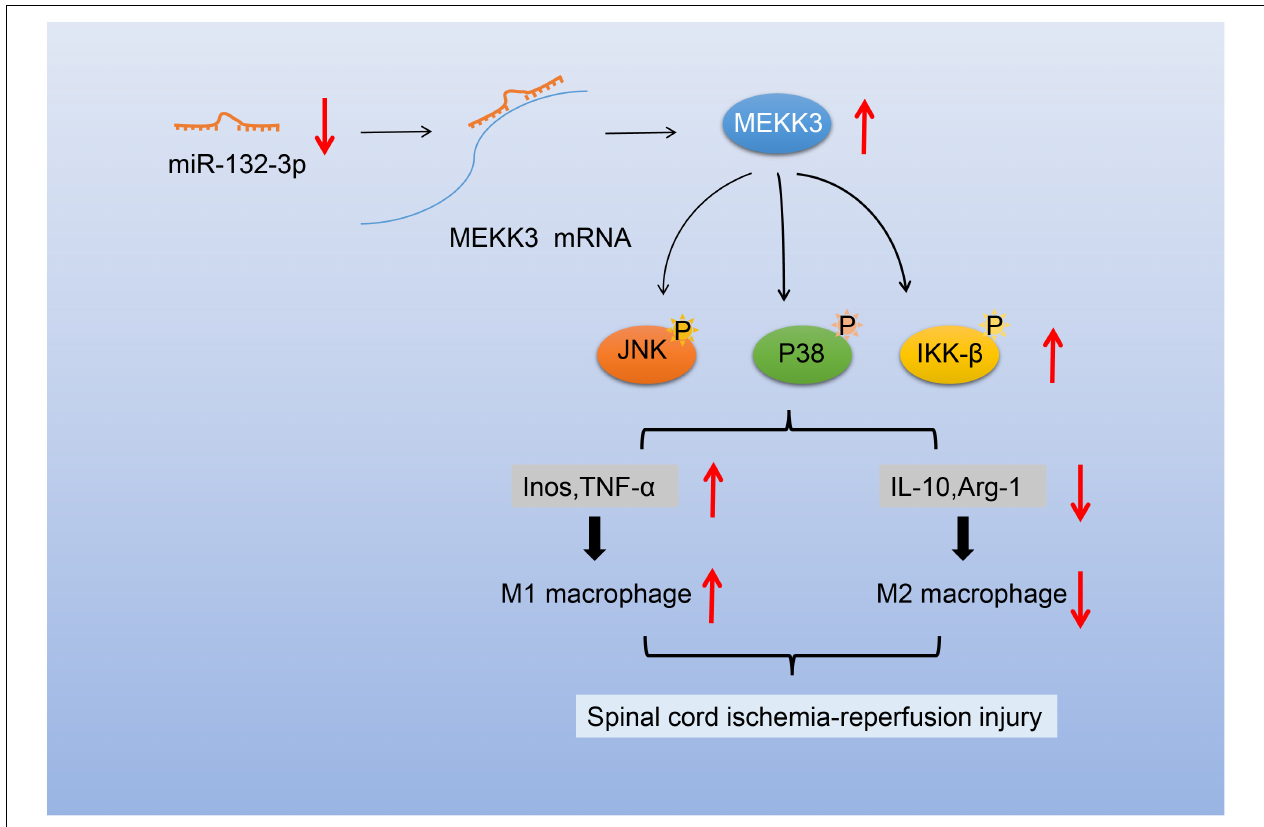
FIGURE 7 | Schematic diagram of the mechanism of miR-132-3p in SCIR injury rats. miR-132-3p targets MEKK3 and negatively regulates the MEKK3 expression to inhibit activation of the NF- κ B and p38/JNK signaling pathways, thus inhibiting the M1 polarization of macrophages and further alleviating the motor dysfunction caused by SCIR